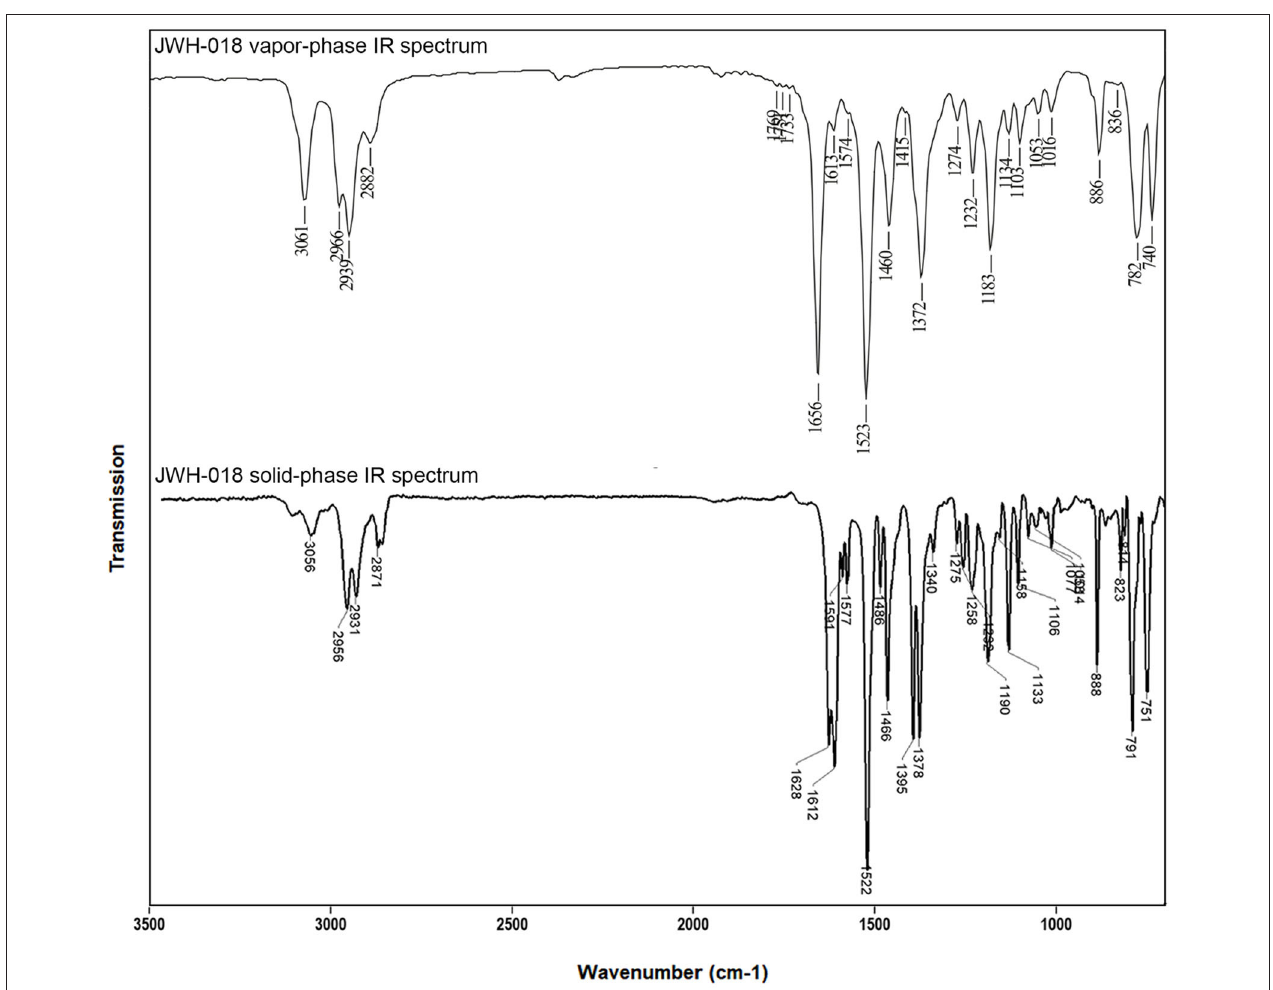
FIGURE 2 | Vapor-phase (top) and solid-phase (bottom) mid-IR spectra for JWH-018 (1-naphthalenyl(1-pentyl-1H-indol-3-yl)-methanone), at a resolution of 8 and 4 cm − 1 , respectively. Top part of this figure has been reprinted from Spectrochimica Acta Part A: Molecular and Biomolecular Spectroscopy, 196, Lewis W. Smith, Amber Thaxton-Weissenfluh,Younis Abiedalla, Jack De Ruiter, Forrest Smith, C. Randall Clark, Correlation of vapor phase infrared spectra and regioisomeric structure in synthetic cannabinoids, page 10, Copyright 2018, with permission from